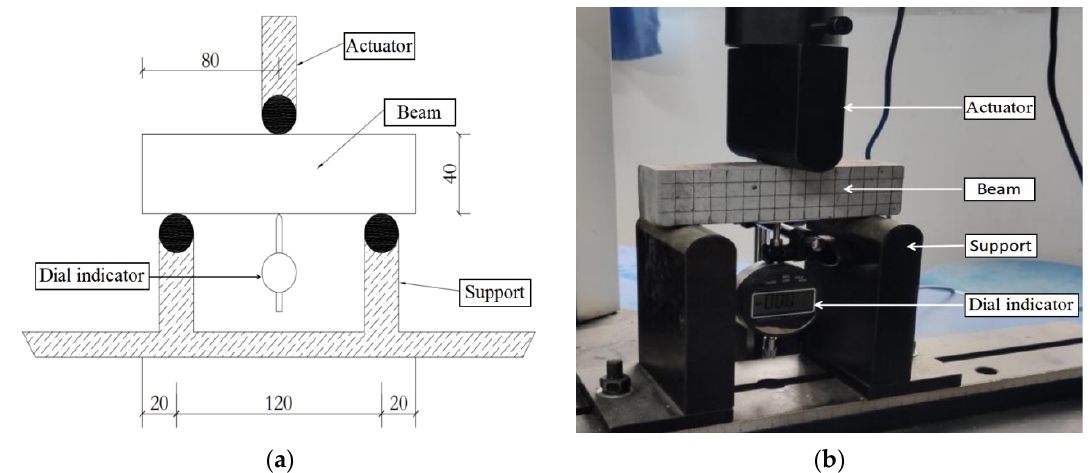
Figure 7. The loading device of the three-point bending test: ( a ) Device diagram; ( b ) Device picture. The displacement control was used for cyclic loading, and the loading speed was 0.6